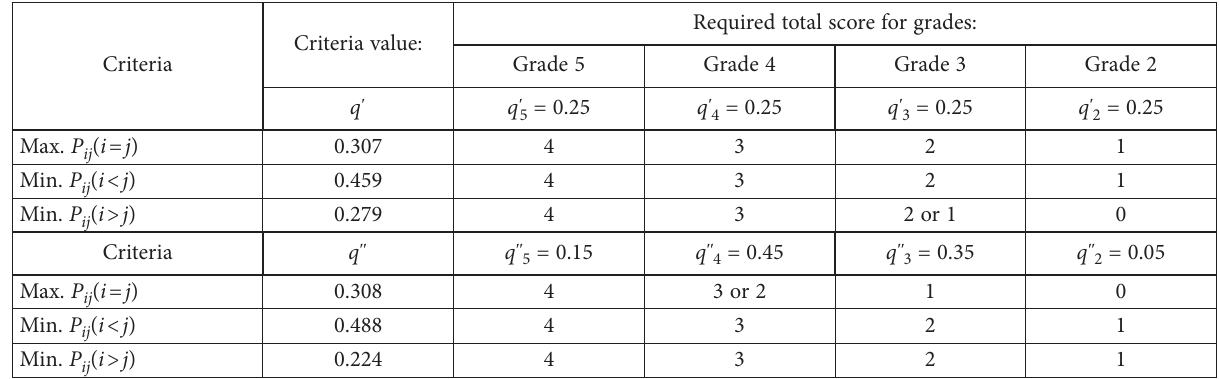
Table 3. Required total score for grades and error